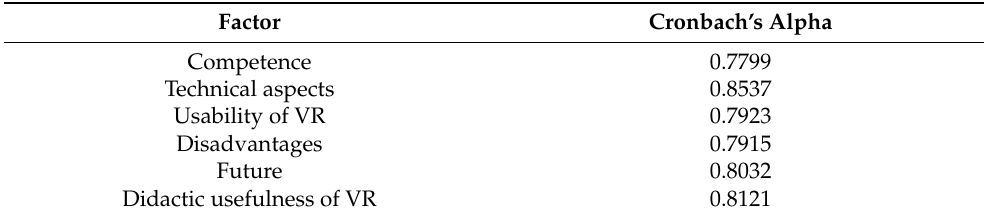
Table 1. Cronbach’s alpha parameters of the different factors of the questionnaire.